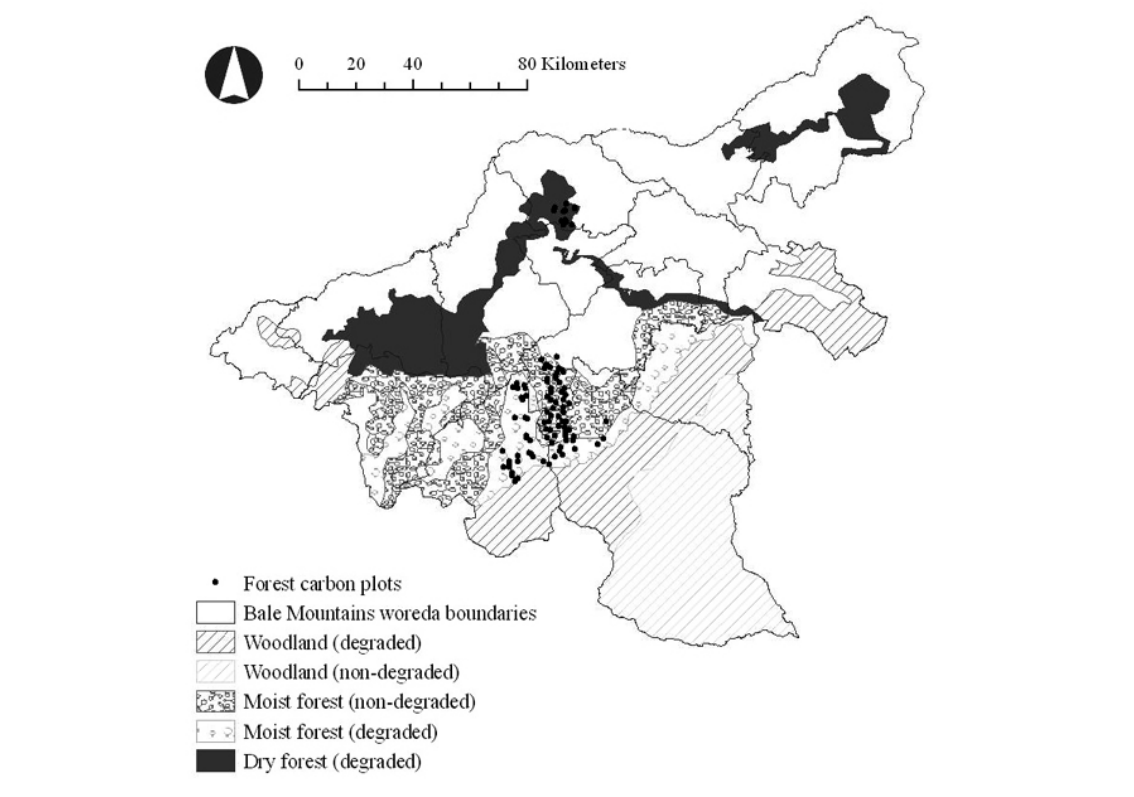
Fig. 1 . Forest cover map of the Bale Mountains showing the location of forest plots used to estimate mean carbon stocks and forest